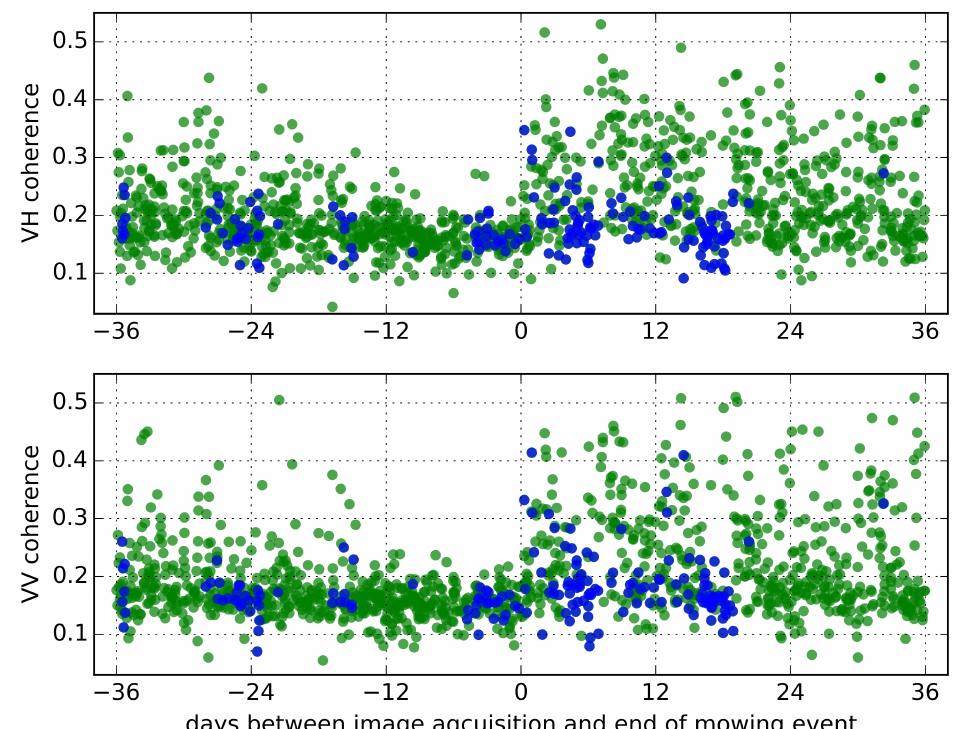
Figure 7. Scatterplot of coherence values and time separation between the first image acquisition in coherence pair and a mowing event. Blue dots mark the coherence values with 3-h precipitation estimates >0.25 mm.